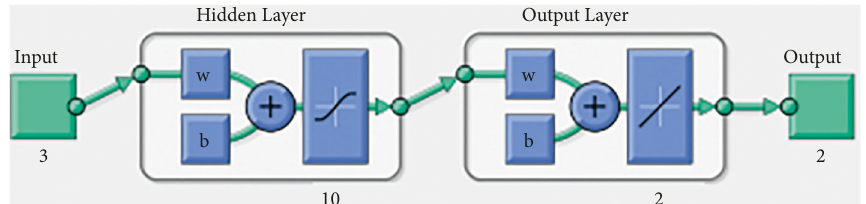
Figure 8: Feed forward neural network architecture.